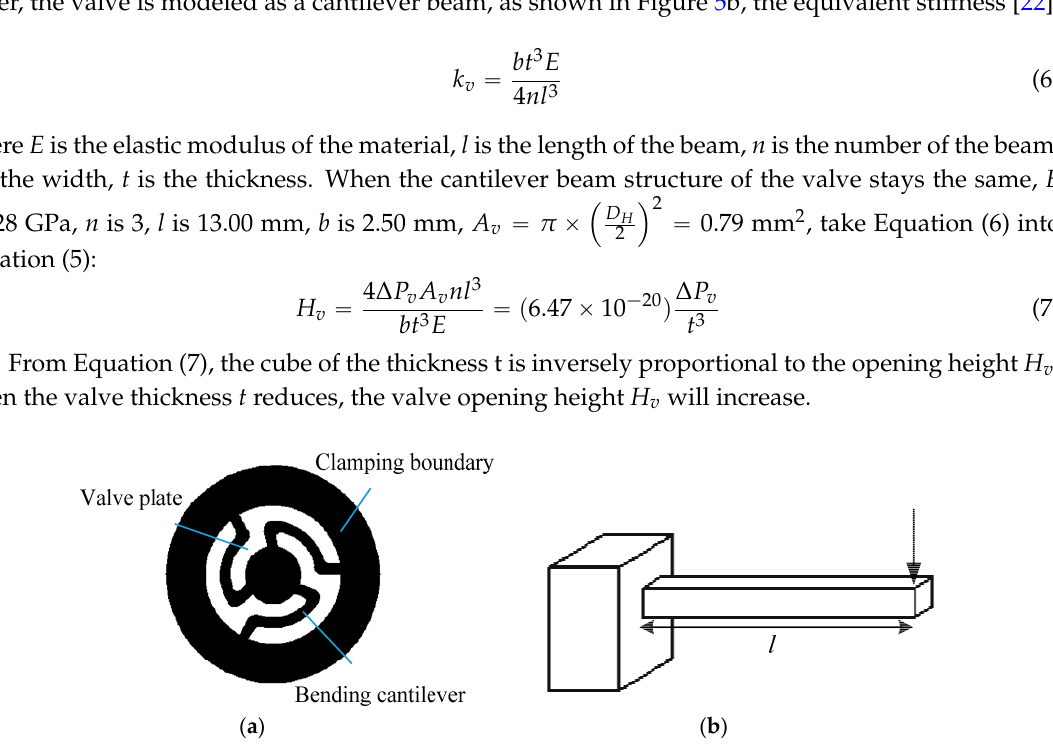
Figure 5. Valve bending cantilever beam. ( a ) Structure; ( b ) Simplified force analysis.